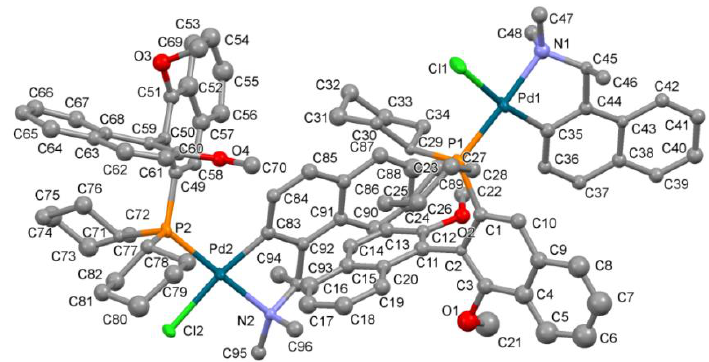
Figure 3. Labeling scheme of atoms in coordination units of Pd complex 12 . Hydrogen atoms and solvent molecules were omitted for clarity. Table 18. Crystal data and structure refinement for Pd complex and cocrystal of 9 with TADDOL.